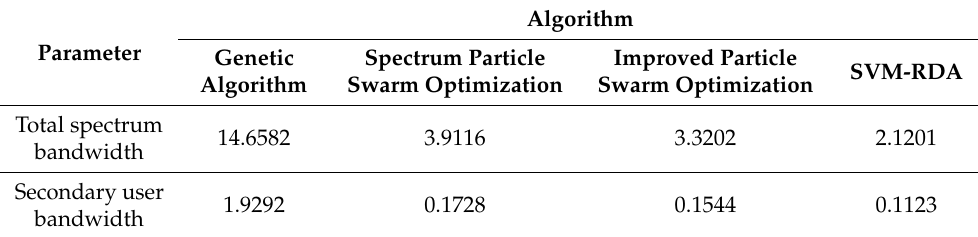
Table 3. Bandwidth allocation for the secondary user.